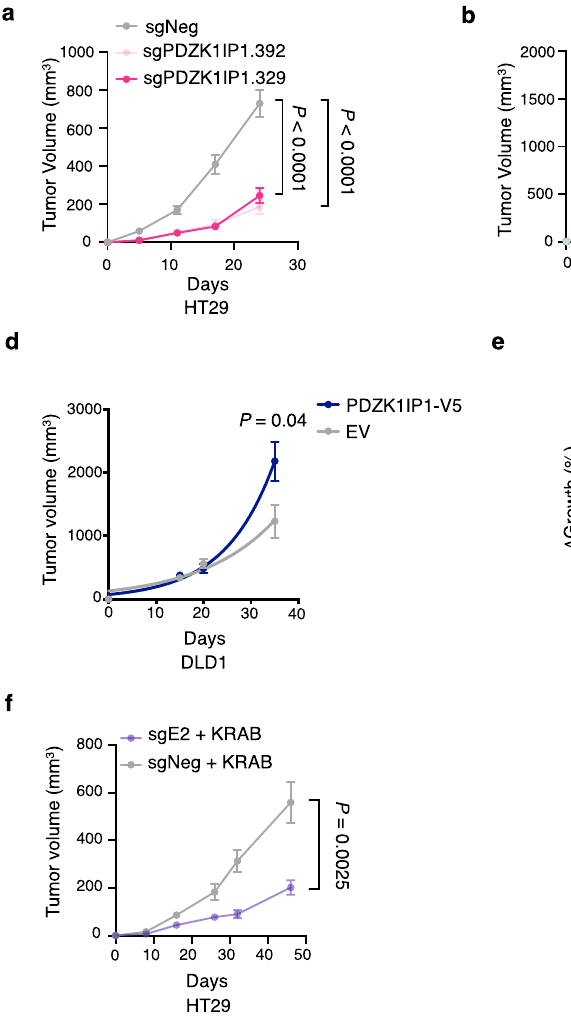
vector, OE – PDZK1IP1-V5. Δ Growth presented as(KO-WT)aspercentage ofWT, or (OE-EV) as a percentage of EV. Data presented as mean ± s.e.m. Signi fi cance was determined using two-sided Studen t ’ s t -test. HT29 KO and WT, as well as DLD1 KO and WT in vivo ( n =10 mice per group). HT29 KO and WT, as well as DLD1 KO and WT in vitro ( n =6 biological replicates). f Growth curves of HT29 cellswith CRISPR dCas9-KRAB interference of the E2 region of the PDZK1IP1 SE (sgE2), and sgNeg subcutaneous xenograft tumors ( n =8 mice per group.) 1 million cells injected per mouse. Data presented as mean ± s.e.m. Signi fi cance was determined using two- sided Student ’ s t test. Source data are provided as a Source Data fi